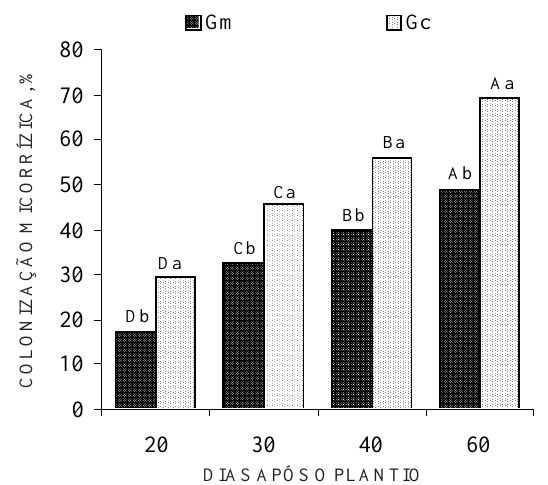
Figura 1. Colonização micorrízica em raízes de milho, inoculadas com FMAs: Gigaspora margarita (Gm) ou Glomus clarum (Gc) aos 20, 30, 40 e 60 dias do plantio. Médias seguidas de mesma letra não diferem entre si pelo teste Tukey a 5 %. As barras com letras maiúsculas comparam as médias entre as épocas avaliadas num mesmo FMA, e as com minúsculas comparam médias entre os FMAs numa mesma